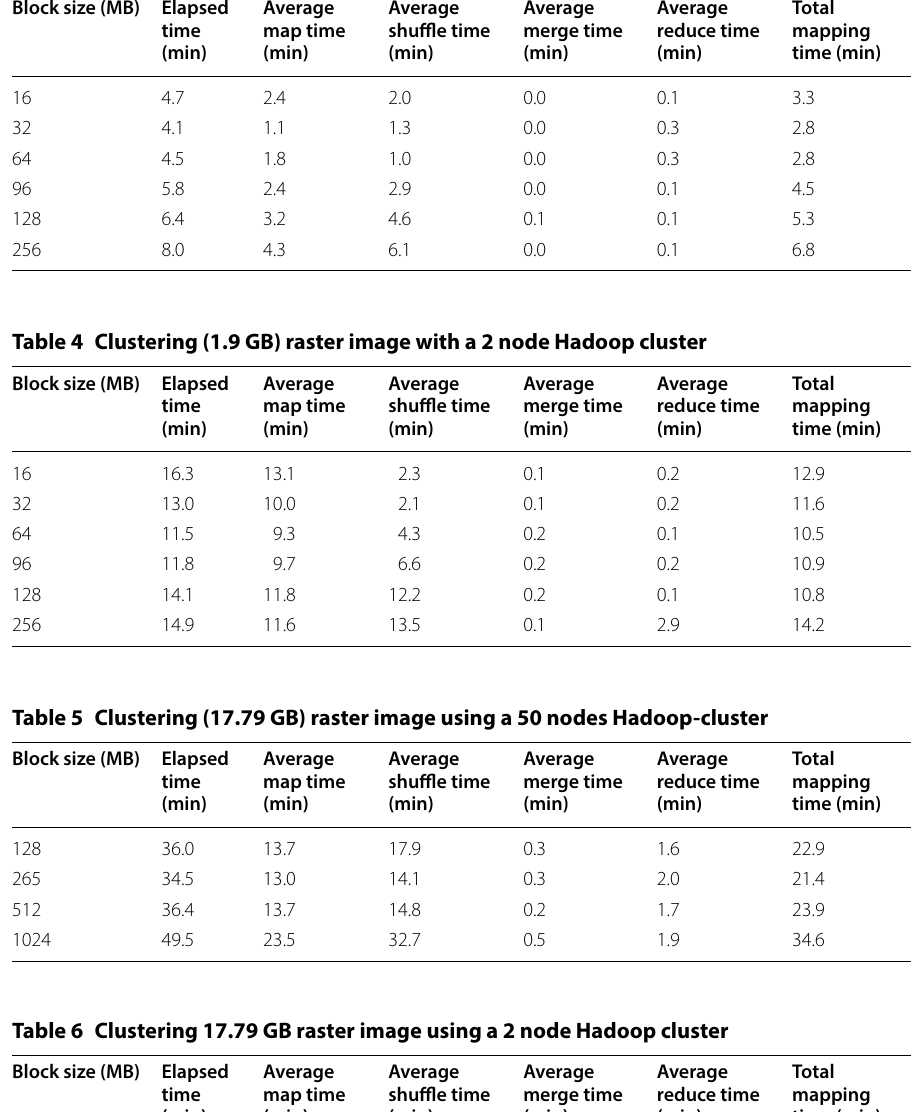
Table 3 Clustering (1.9 GB) raster image with a 50 node Hadoop cluster Block size (MB) Elapsed time